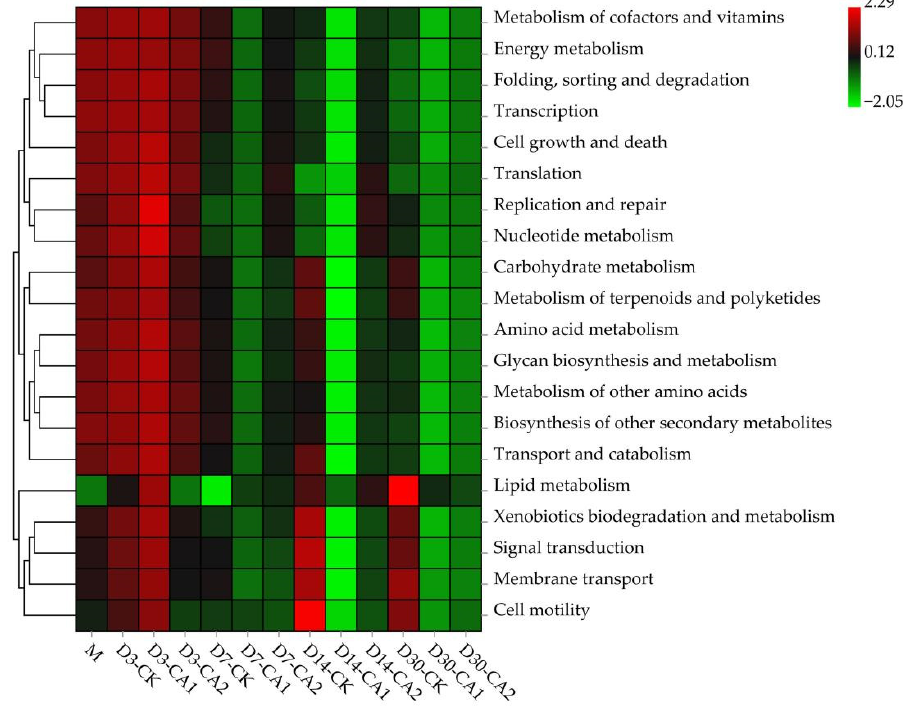
Figure 6. Heatmap of 16S rDNA gene-predicted functional profiles obtained with PICRUSt2 (M, pre-ensiled material; CK, the control; CA1, 1% citric acid; CA2, 2% citric acid; D3, 3 days of ensiling; D7, 7 days of ensiling; D14, 14 days of ensiling; D30, 30 days of ensiling).